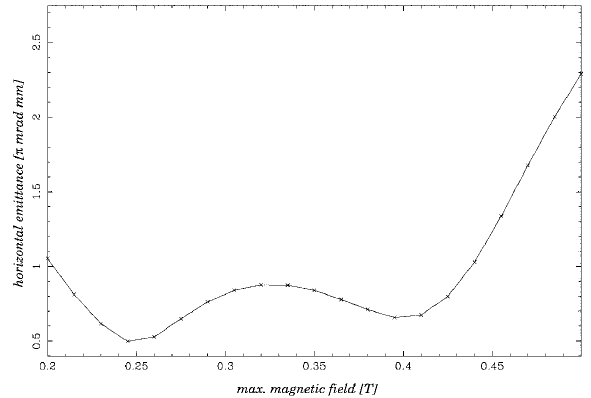
FIG. 2. Horizontal emittance obtained from ASTRA [6] simu- lations at the exit of the rf gun vs solenoid field at the cathode. The complete setup, which has been investigated by